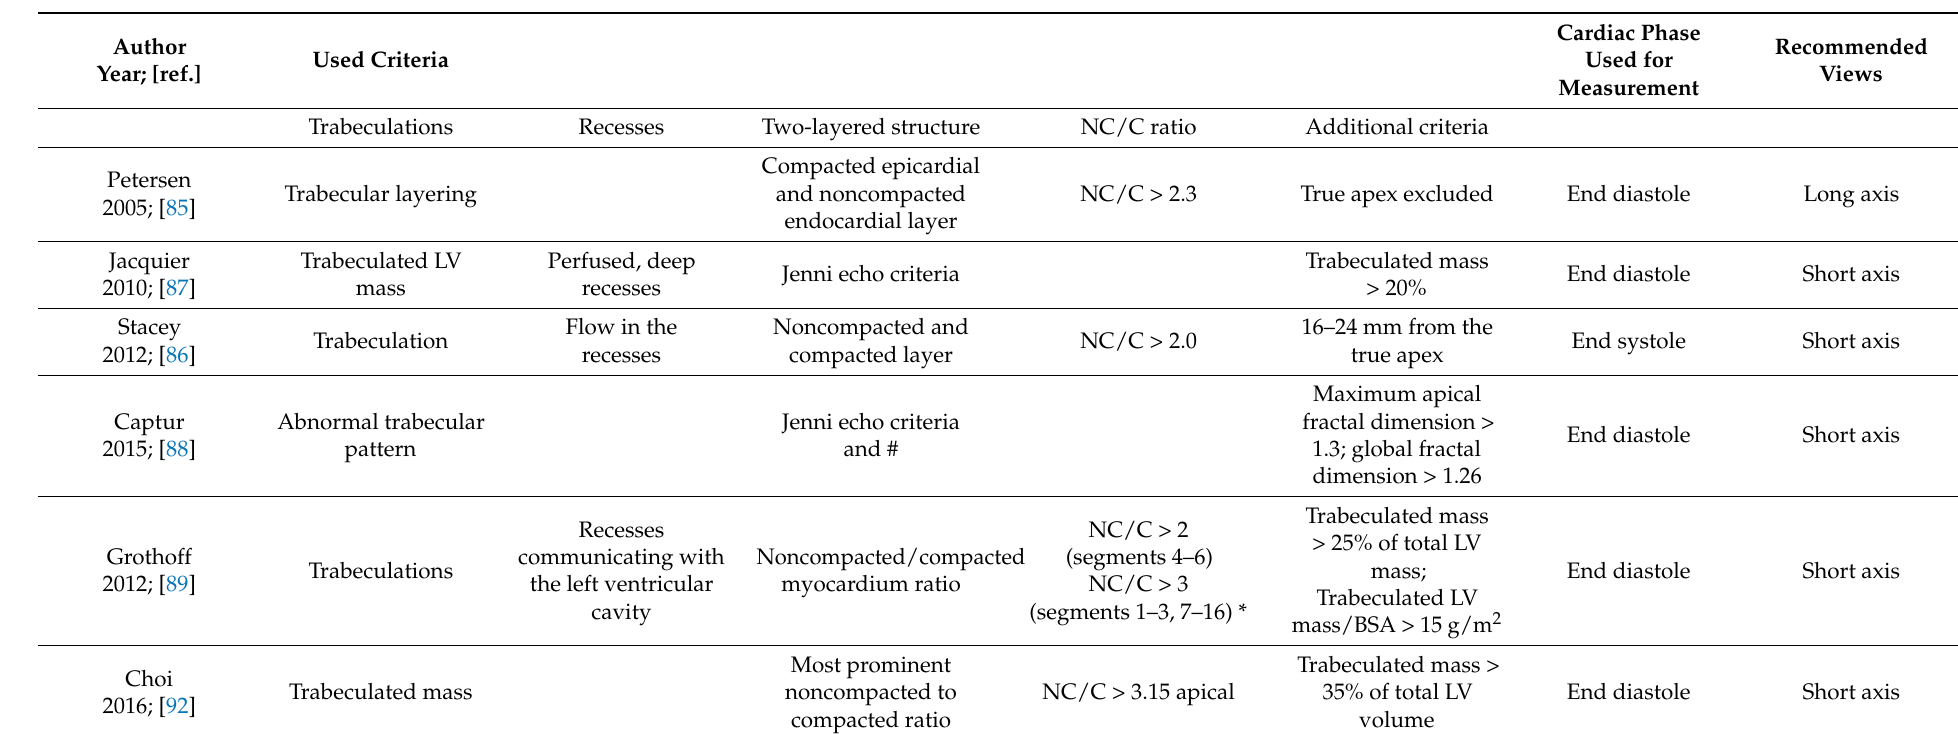
Table 6. Different CMR criteria for the diagnosis of